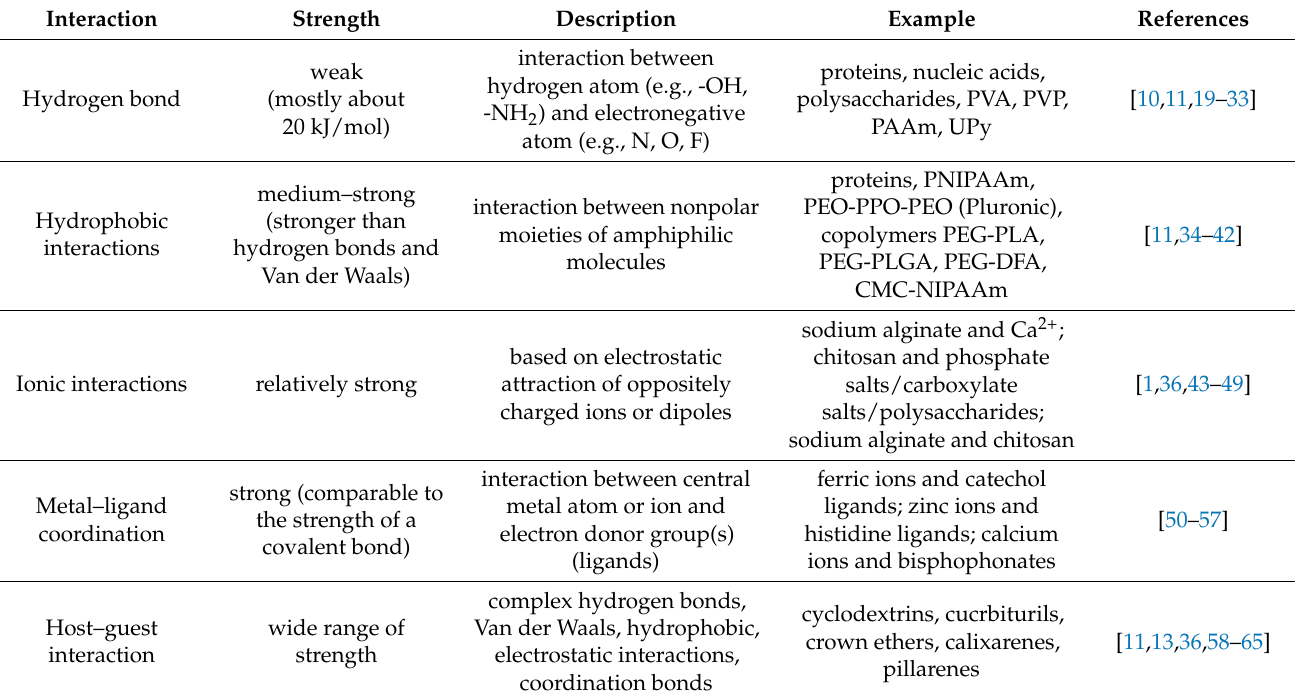
Table 1. Comparison of strength and range of the non-covalent interactions.